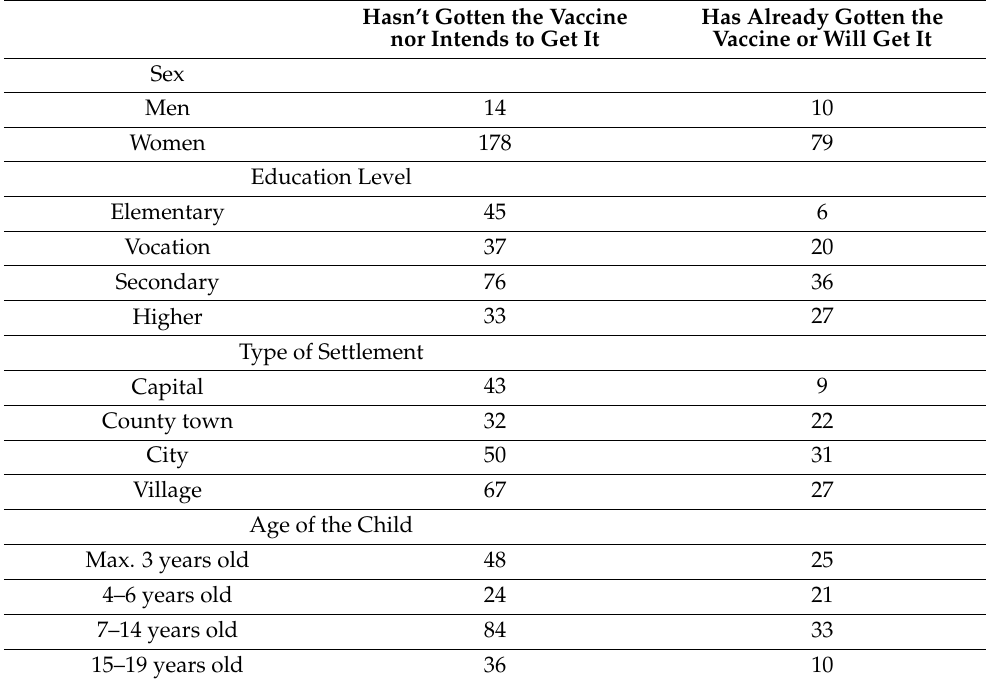
Table A7. Crosstabulation of the attitude towards the Piresian vaccine with different socio- demographic dimensions. Cell counts.